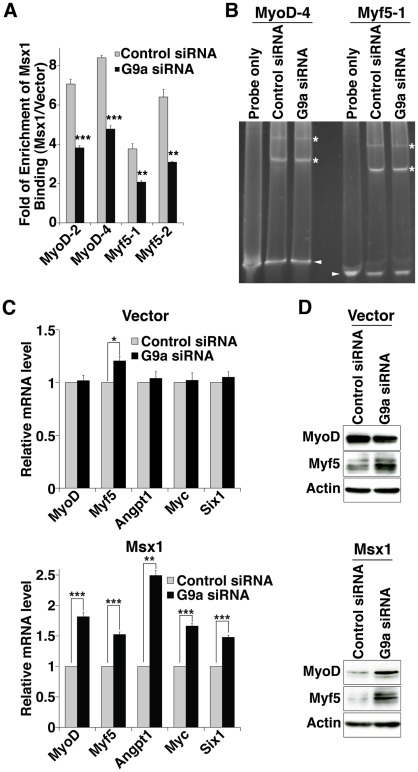
Association of Msx1 with G9a is required for transcriptional repression.(A) ChIP-qPCR analyses showing relative Msx1 binding in C2C12 cells expressing or lacking Msx1 as well as a control or G9a siRNA. ChIP data are expressed as fold enrichment of Msx1 binding in C2C12 cells expressing Msx1 versus control cells lacking Msx1. (B) Gel shift analyses were done using nuclear extracts from C2C12 cells expressing Flag-Msx1 as well as the control or G9a siRNA with DNA sequences corresponding to the MyoD CER (MyoD-4) and Myf5-1. The * indicate the protein-DNA binding bands, the arrowhead indicates the free probes. (C) Expression levels of Msx1 target genes in Msx1-expressing or lacking Msx1 C2C12 cells also expressing the control or G9a siRNA. Data are expressed as the fold change of mRNA relative to that of the control siRNA cells. The * indicate the following: ***P<0.0001, **P<0.001, *P<0.01. (D) Western blots analyses showing levels of MyoD and Myf5 protein following by G9a knock-down in Msx1-expressing or lacking Msx1 C2C12 cells.